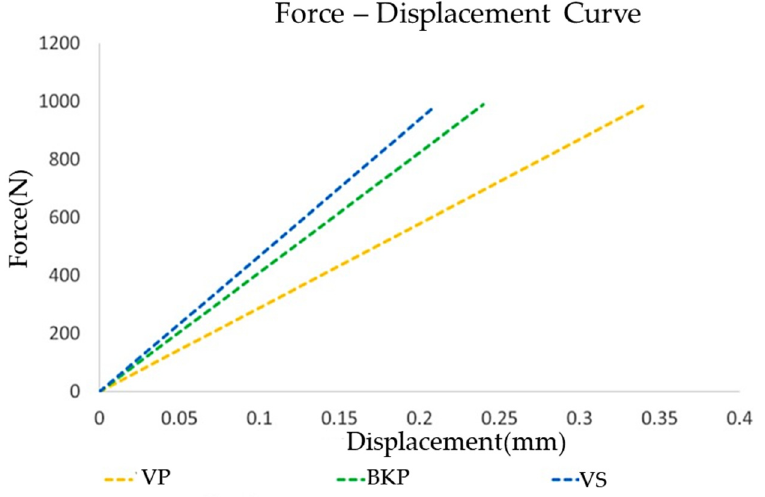
Figure 6. Finite element stress nephogram of interfacial stress at upper L1 endplate. ( A ): Flexion. ( B ): Extension. ( C ): Lateral bending. ( D ): Axial rotation.